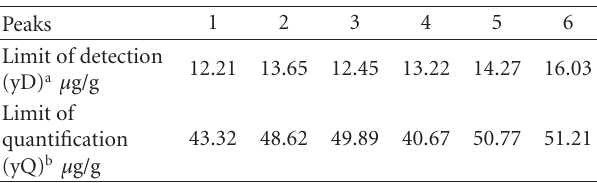
Table 6: Limits of detection and quantitation.